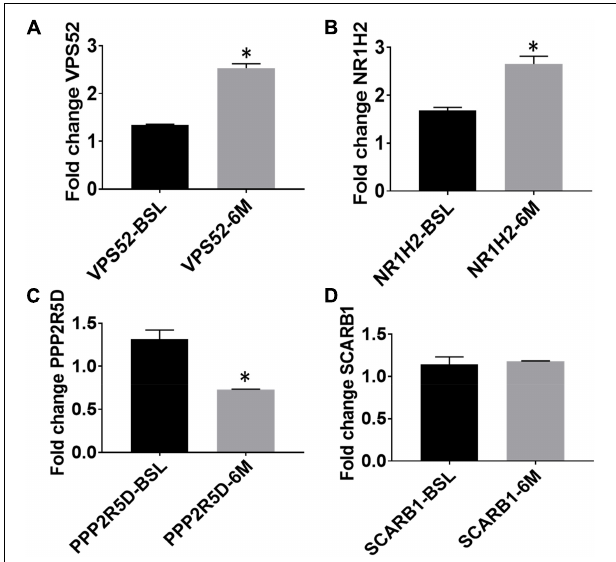
FIGURE 3 | Expression levels of top exercise induced hypomethylated genes at baseline and following aerobic exercise intervention ( A , VPS52; B , NR1H2; C , PPP2R5D; D, SCARB1). Gene expression by quantitative RT-PCR; mRNA levels of top 4 hypomethylated genes for VPS52; NR1H2; PPP2R5D; SCARB1 at baseline and post-exercise. Note: * Indicates statistically significant training-induced changes in gene expression levels.